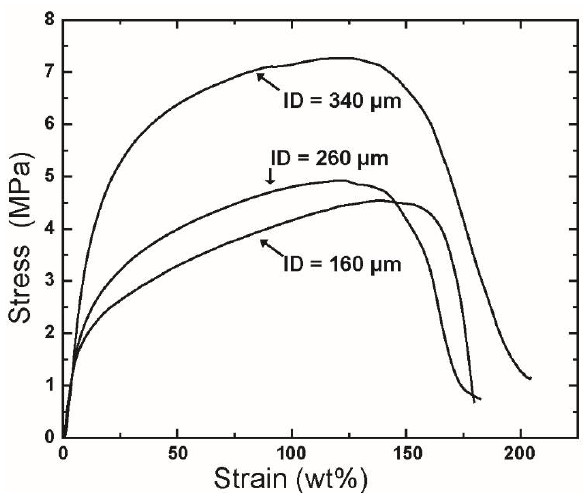
Figure 10. Tensile stress-strain curves of the fiber mats produced using needles with various inner diameters. Centrifugal spinning condition: polymer solution concentration, 10 wt %; rotational speed, 15,000 rpm; collection distance, 10 cm. Table 3. Mechanical properties of rPET fibers prepared using needles with various inner diameters.